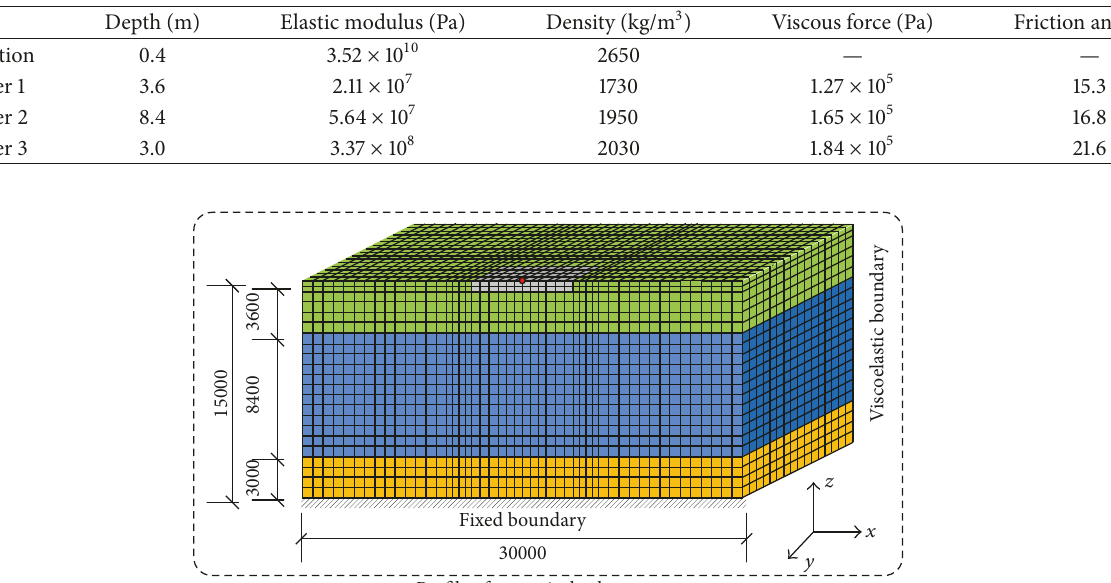
Figure 5: Model of the numerical